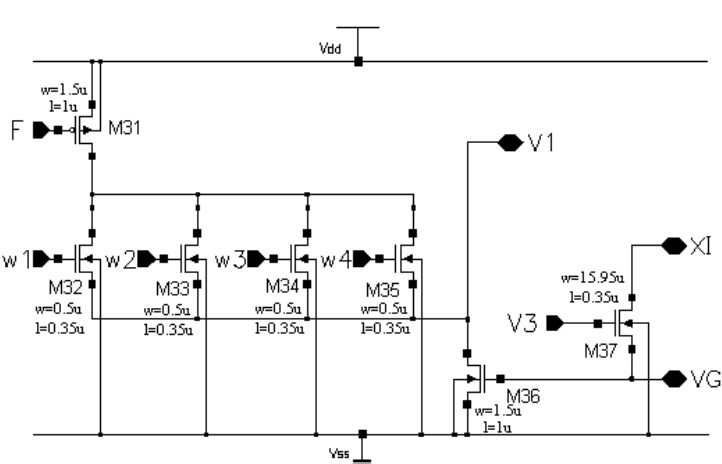
Figure 6. A schema of the excitatory synapse